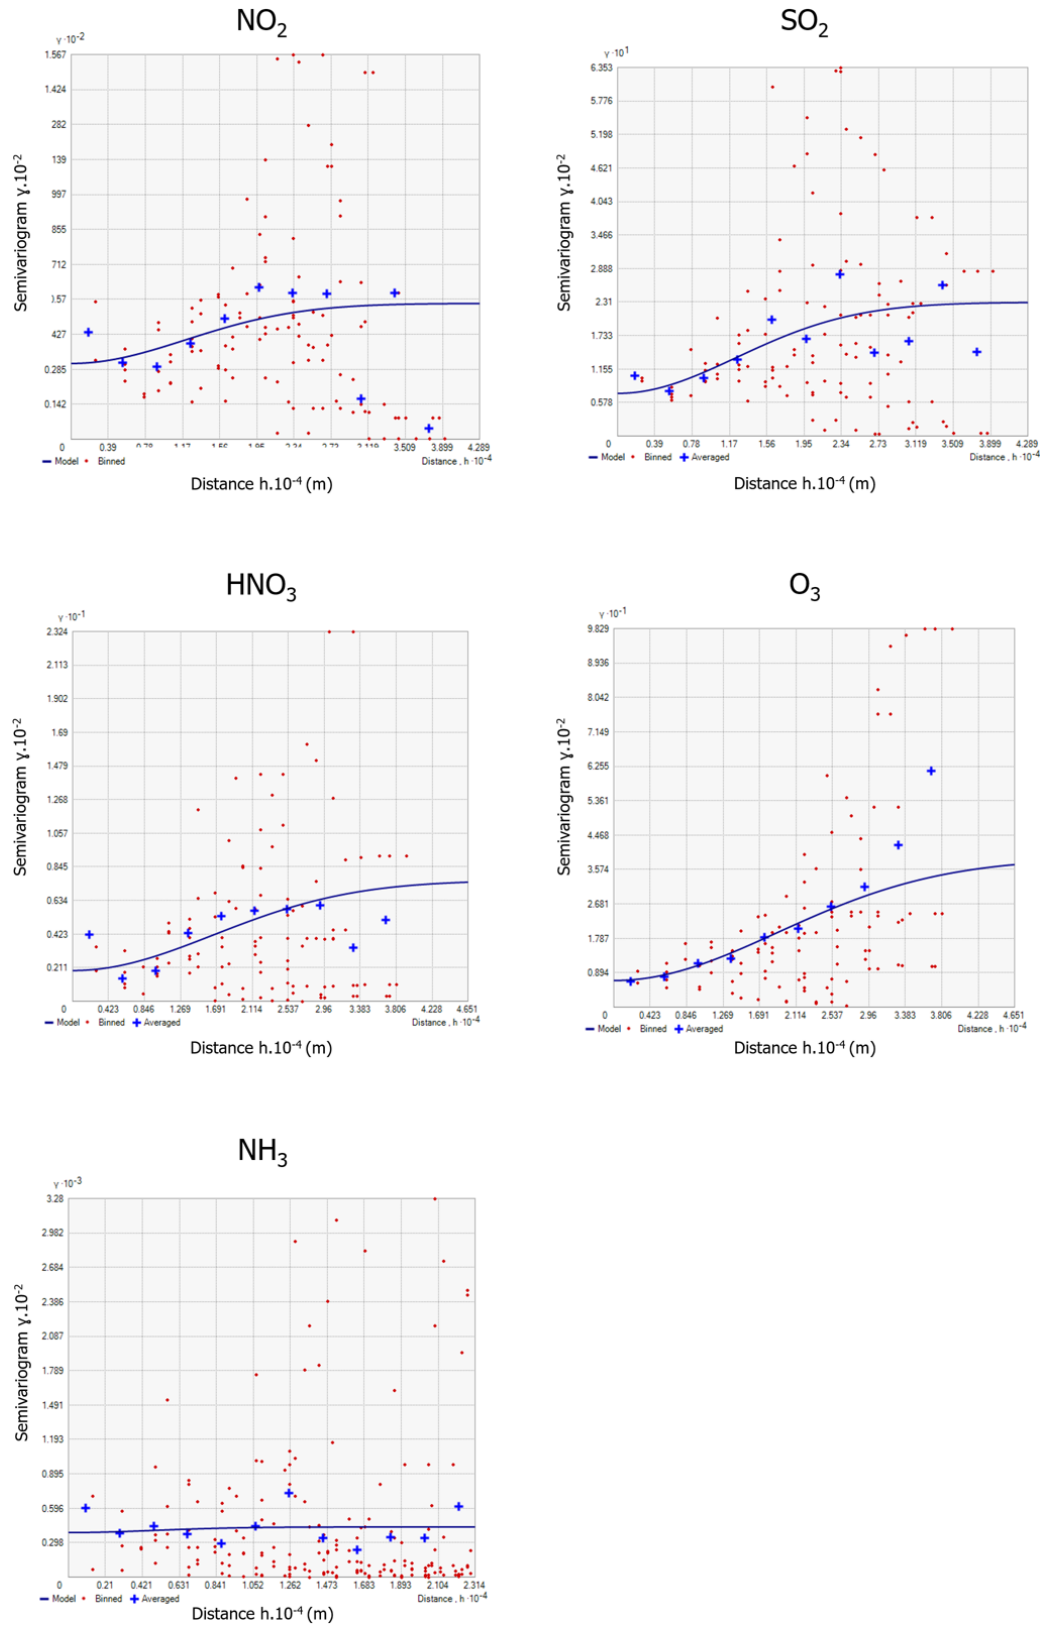
Figure 5. Empirical semivariogram for each